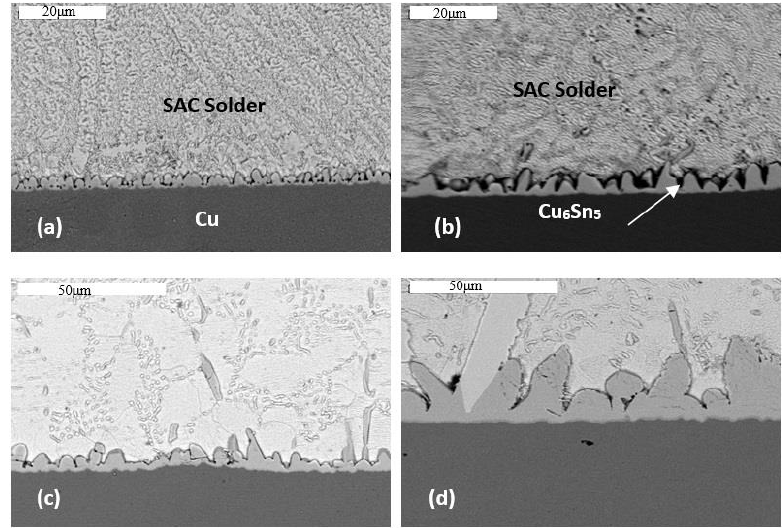
Figure 3. Interfacial IMC of SnAgCu/Cu interface after reflow for ( a ) 90 s, ( b ) 150 s, ( c ) 210 s and ( d ) 270